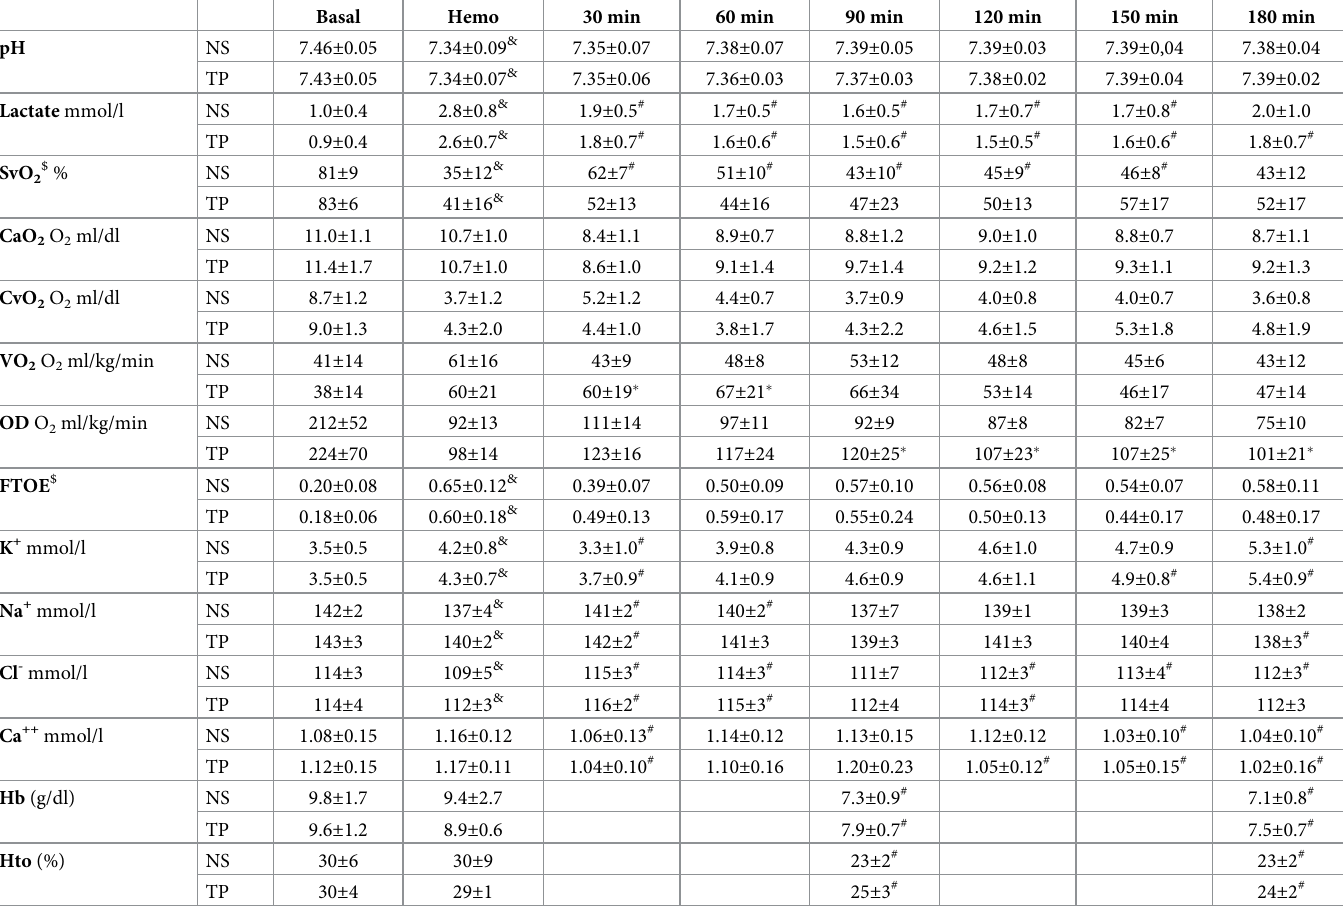
Table 2. Blood tests